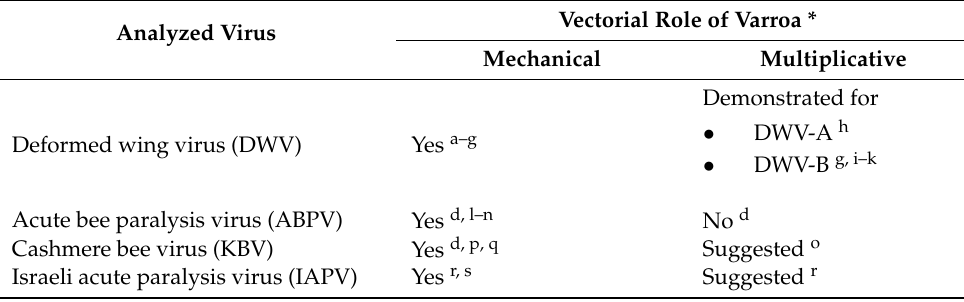
Table A1. Review of the vector role of varroa in transmission of honeybee